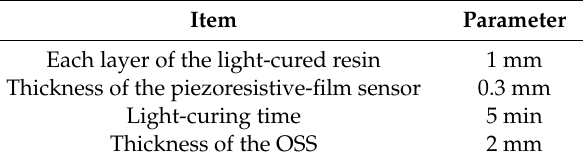
Figure 7. Data acquisition from stress sensor system. Table 1. Reasonable parameters for the sandwich method.